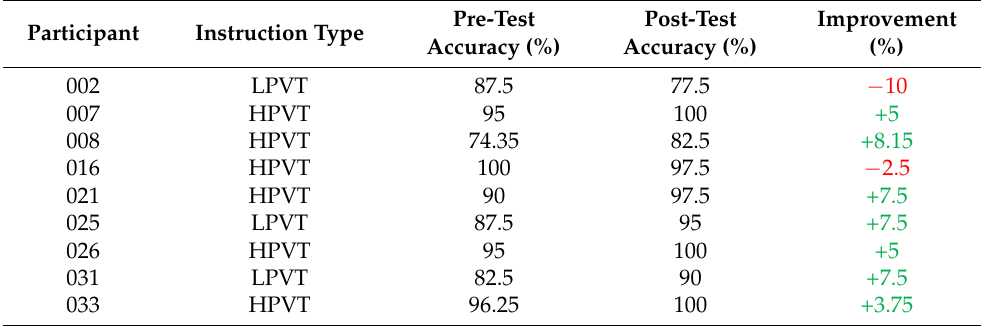
Table 6. Heritage speaker participants’ results. Improvement in accuracy is marked in green and decrease in accuracy is marked in